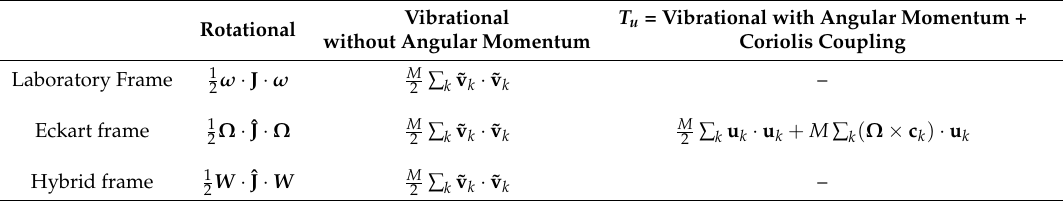
Table 2. The various contributions to the total kinetic energy in the laboratory, the Eckart frames and hybrid